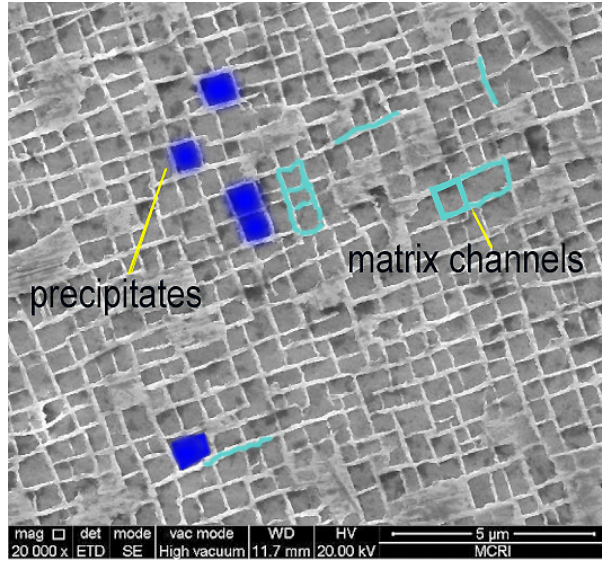
Figure 1. Microstructure of nickel based single crystal superalloys